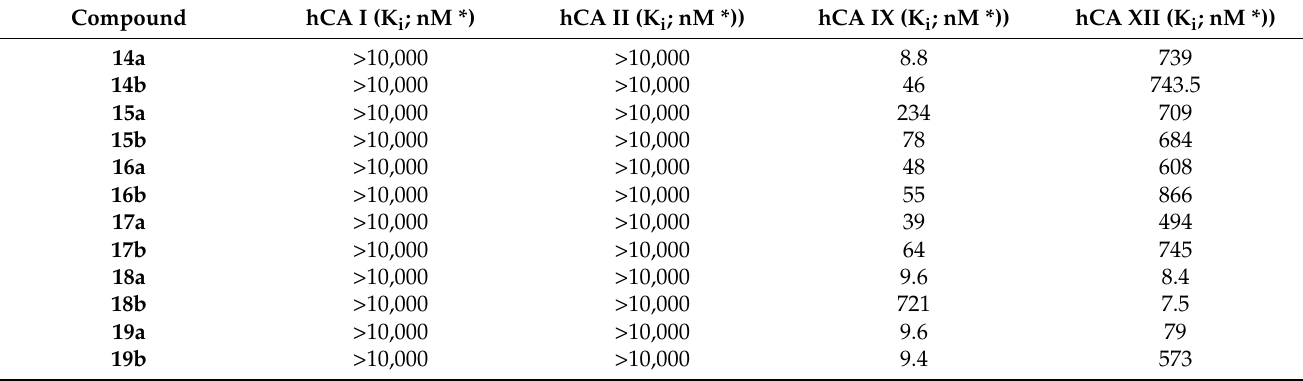
Table 1. Inhibition data of hCA isoforms I, II, IX and XII with compounds 14a,b – 22a,b and 23b and coumarin ( COU ) by the stopped flow CO 2 hydrase assay [12].